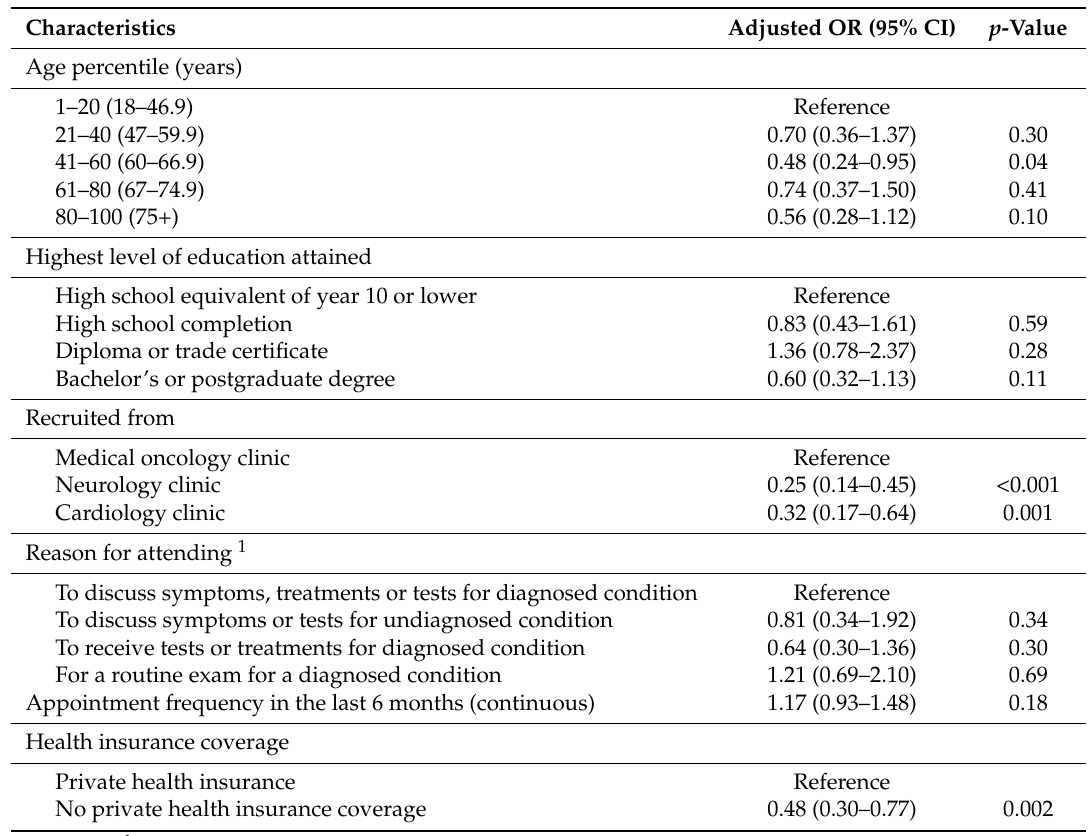
Table 9. Adjusted odds for selecting “Improved hospital